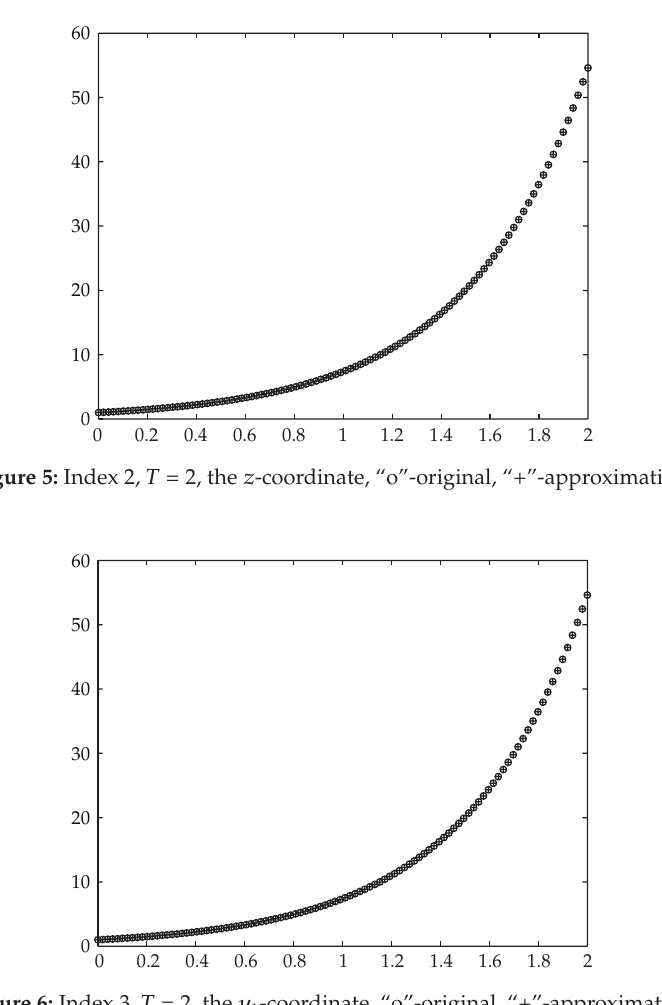
Figure 6: Index 3, T (cid:8) 2, the y 1 -coordinate, “o”-original, “ (cid:9)